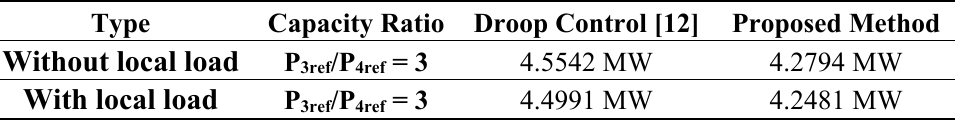
Table 6. Copper loss of station